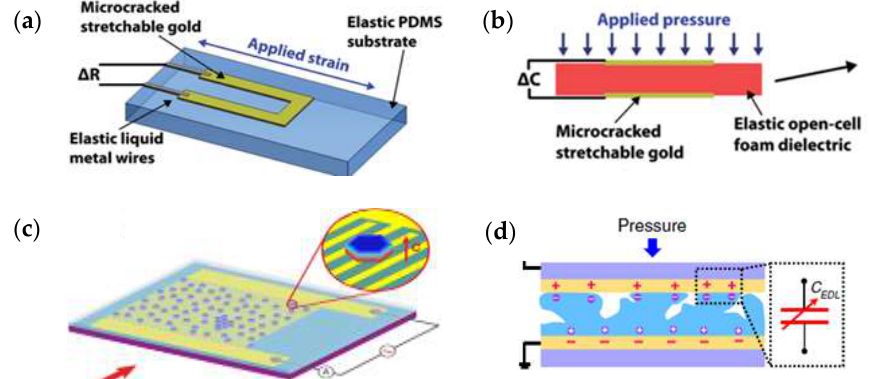
Figure 3. Four typical pressure sensing mechanism. ( a ) Piezoresistive (Reprinted with permission from ref. [65]. Copyright 2015 John Wiley and Sons); ( b ) Capacitive (Reprinted with permission from ref. [65]. Copyright 2015 John Wiley and Sons); ( c ) Piezoelectric (Reprinted with permission from ref. [66]. Copyright 2018 American Chemical Society); ( d ) Ionization (Reprinted with permission from ref. [67]. Copyright 2020, The Authors).